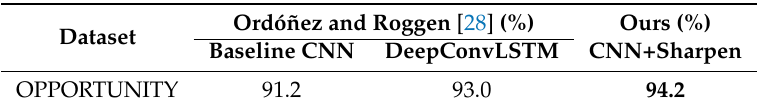
Table 4. F 1 score comparison with state of the art approach on lower body OPPORTUNITY dataset. The number in bold indicates the highest F 1 score.